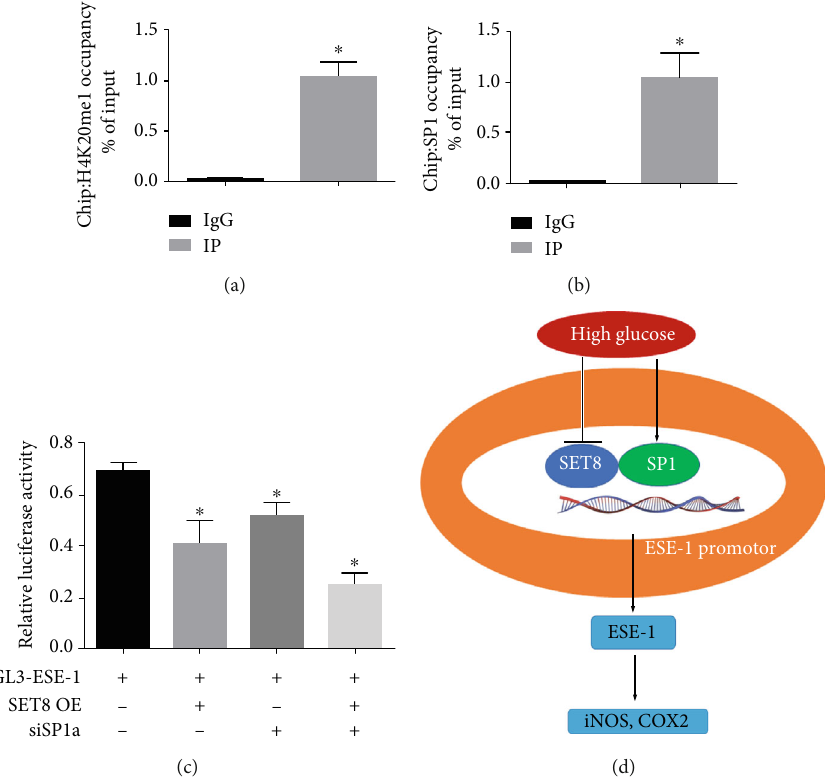
Figure 6: SET domain-containing protein 8 (SETD8) interacts with speci fi city protein 1 (SP1) to regulate E26 transformation-speci fi c sequence transcription factor-1 (ESE-1) expression in hyperglycaemic HUVECs. (a) H4K20me1 is enriched at the ESE-1 promoter region. (b) SP1 is enriched at the ESE-1 promoter region. (c) Luciferase reporter assays indicated that SETD8 overexpression not only attenuated ESE-1 promoter activity but also augmented the e ff ect of siSP1a on ESE-1 promoter activity. (d) Schematic representation of the working model. SETD8 OE: SETD8 overexpression; siSP1: small interfering RNA SP1. ∗ P < 0 : 05 , compared with the control